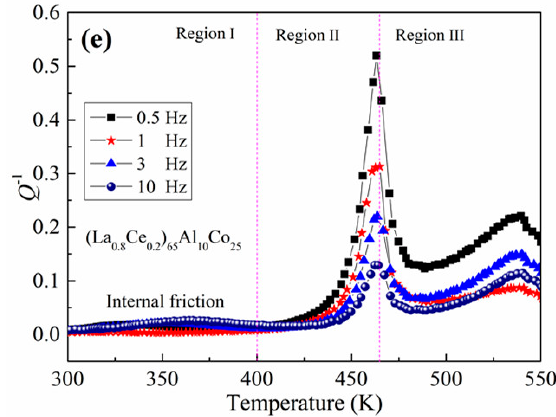
Figure 2. ( a–e ) Q − 1 – T curves of the as-cast LaCe-based BMGs with driving frequencies of 0.5 Hz, 1 Hz, 3 Hz, and 10 Hz, respectively.